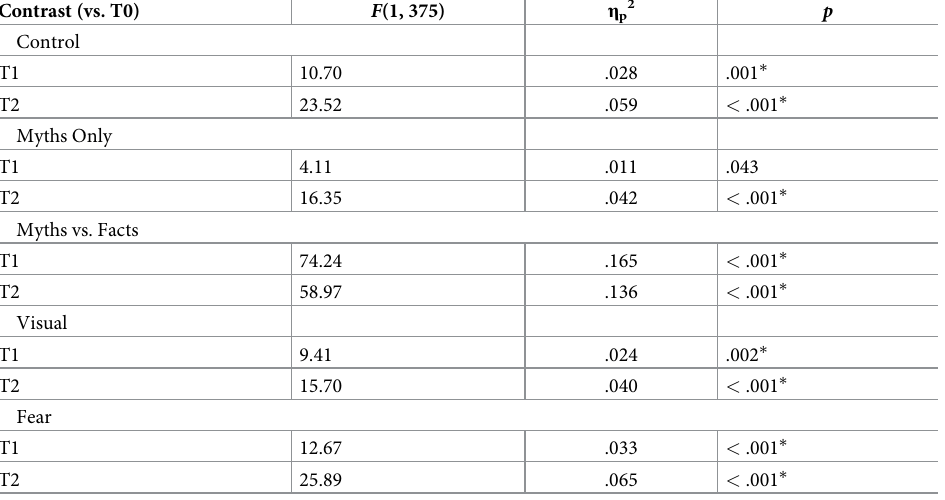
* indicates significance after Holm-Bonferroni correction